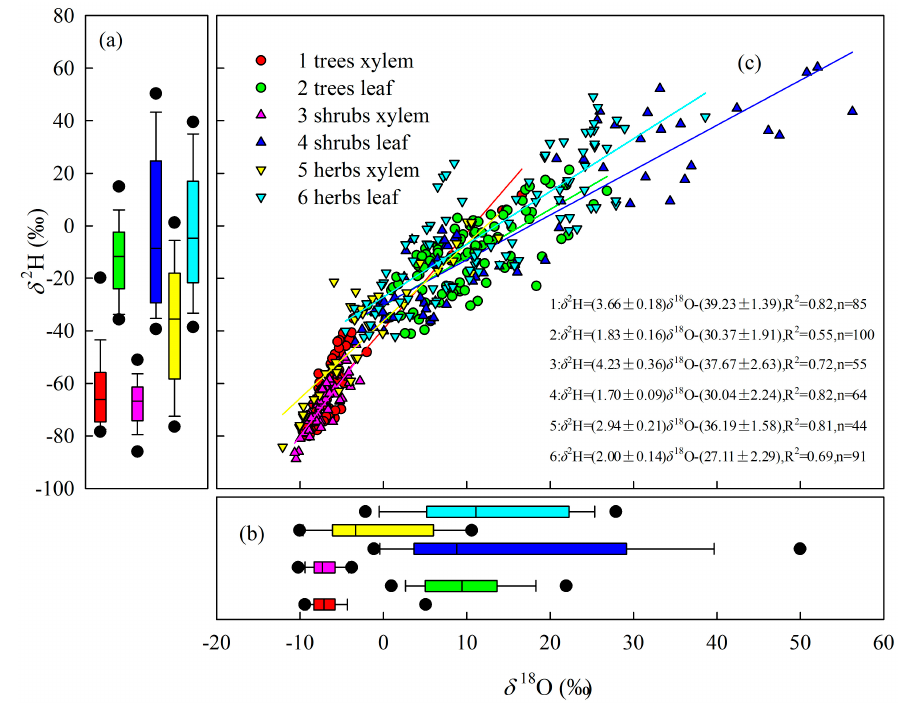
Figure 3. Relationships between δ 2 H and δ 18 O of xylem water and leaf water in different plant types. ( a and b ) are the hydrogen and oxygen isotopic composition of different plant types, respectively, and c is the water line equation of different plant type.